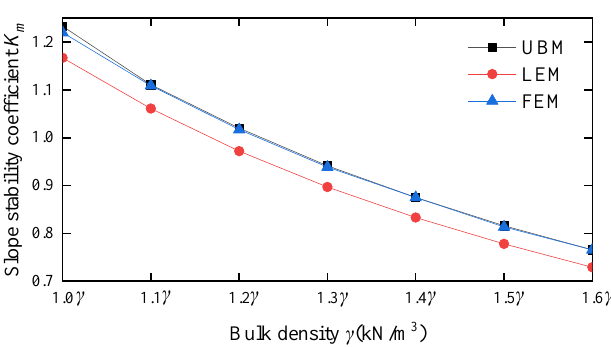
Figure 10. Relationship between bulk density and slope stability coefficient of heterogeneous slope.